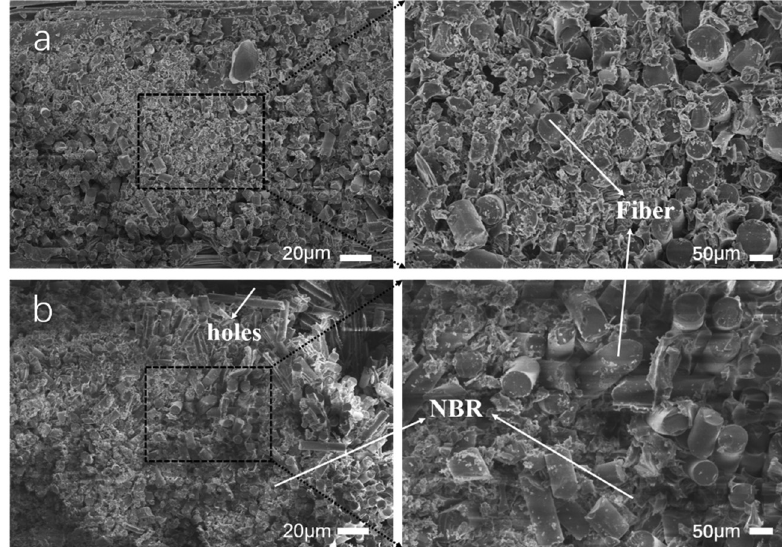
Figure 10: SEM images of fractured surfaces of composites: ( a ) A - 0 and ( b ) A -